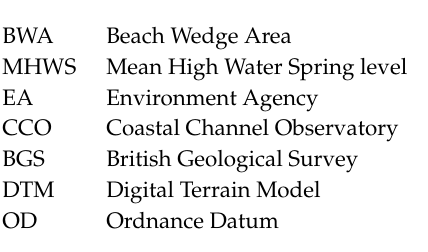
Table A1. Location (x,y) in EPSG:28800—OSGB 1936 / British National Grid of the first point of